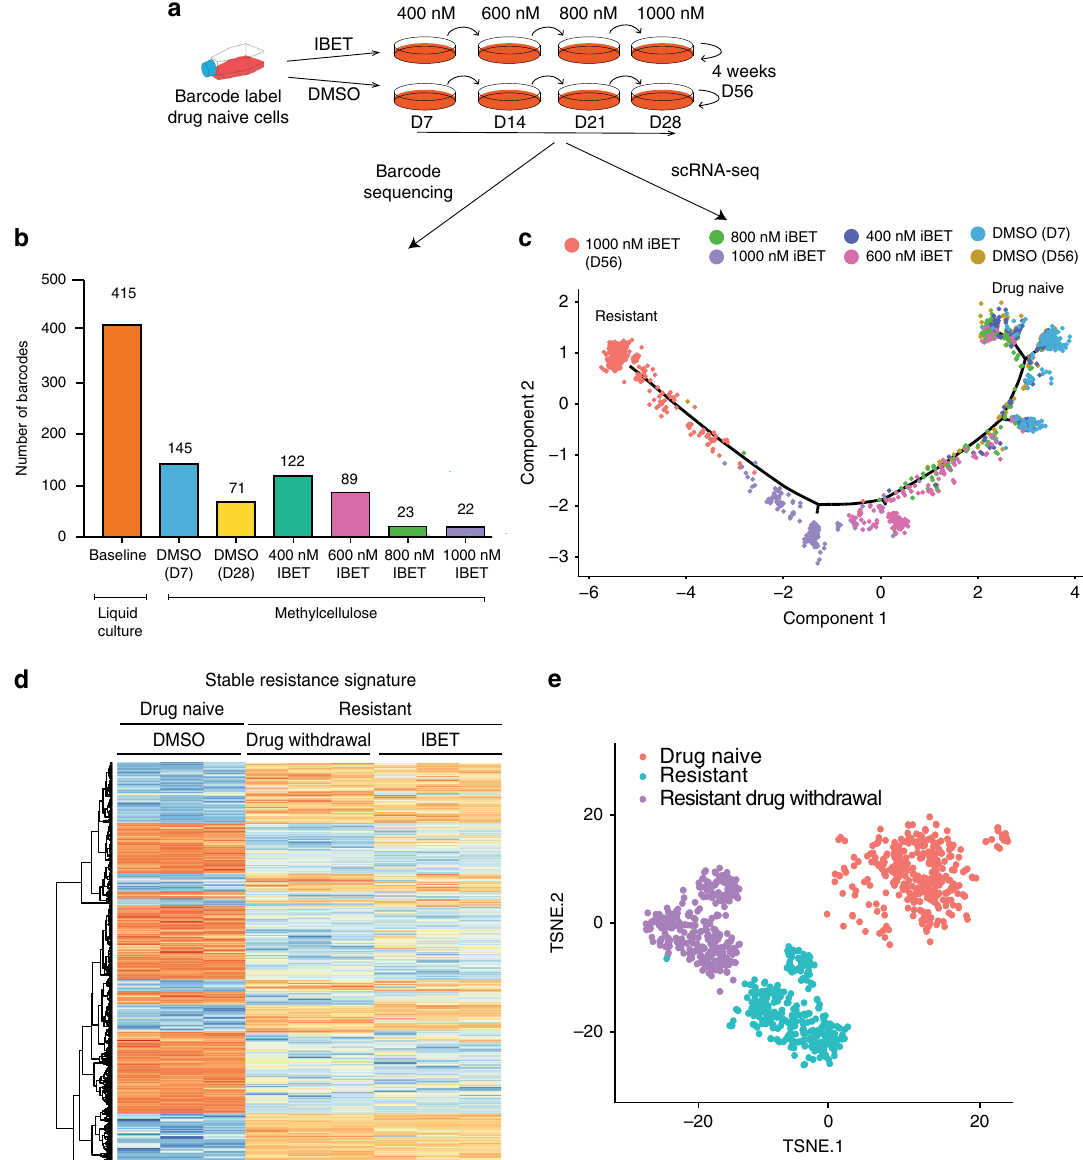
Fig. 2 Transcriptional plasticity underpins stable non-genetic resistance to BET inhibitors. a Schematic highlighting experimental design for following the acquisition of IBET resistance. Drug naïve cells were barcoded in liquid culture and plated in methylcellulose. Cells were then re-plated weekly in either DMSO or escalating concentrations of IBET until they were growing in 1000 nM, where they were maintained for an additional 4 weeks. b Number of barcodes comprising 90% of total reads at fi rst plating that are then serially retained at 90% of the total reads for every re-plating either in DMSO or IBET. Representative of two biological duplicates. c Pseudotemporal ordering of single drug naïve cells serially passaged in DMSO or increasing concentrations of IBET, as de fi ned by the Monocle2 algorithm. Analysis was conducted based on differentially expressed genes between resistant versus drug naïve cells from bulk RNA-sequencing. d Bulk RNA-seq heatmap displaying the expression of genes from the stable resistance signature in drug naïve, resistant, and resistant cells withdrawn from IBET. This subset of genes were determined from fi nding the differentially expressed genes between drug naïve cells and resistant cells withdrawn from IBET for 6 days. e t-SNE analysis of 979 drug naïve cells, resistant cells and resistant cells withdrawn from IBET for 4